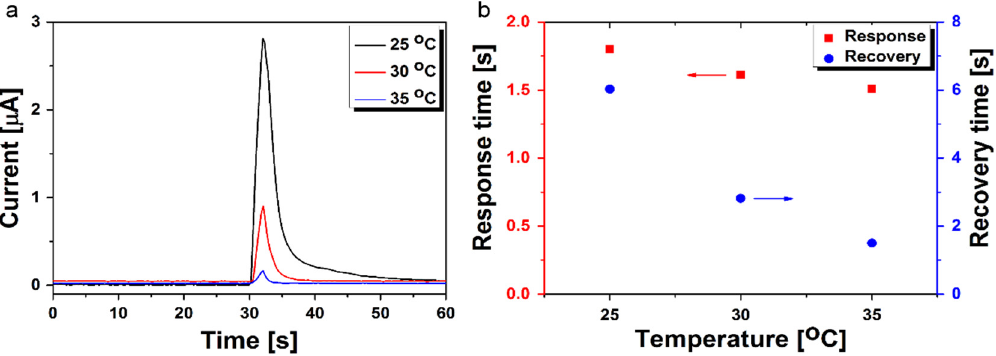
Figure 3. ( a ) Response of MA 3 Bi 2 Br 9 pellets from 30% to 65% RH at several temperatures, ( b ) shortening of response and recovery times with temperature. Table 1. Comparison of several recent humidity